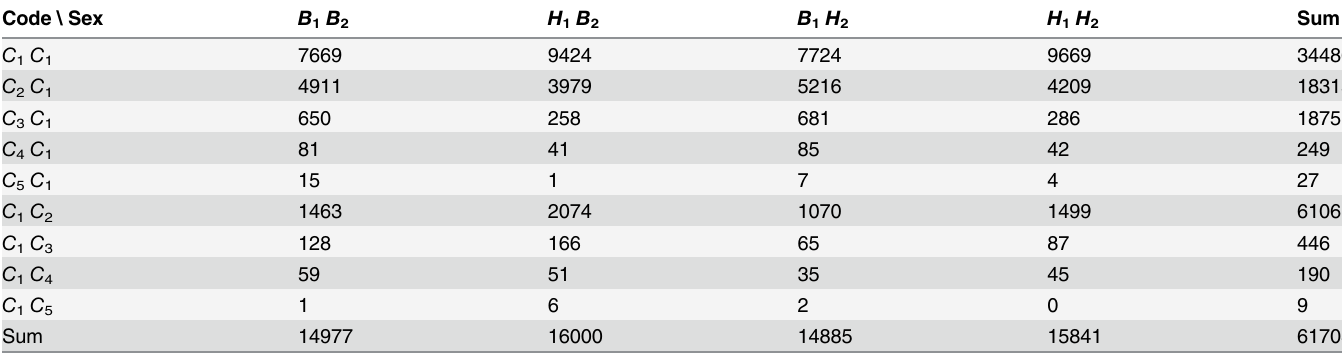
Table 2. Cross-tabulation of calvings and sex of calv. Code \